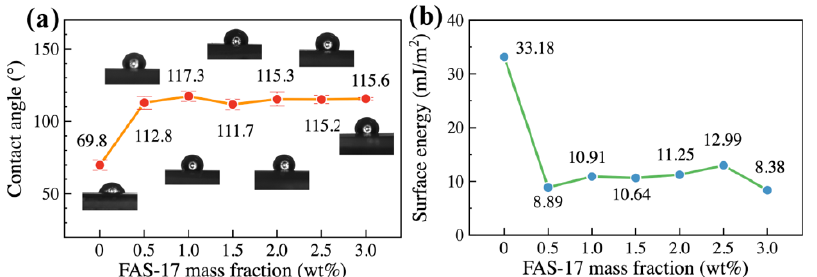
Figure 5. The contact angle (CA) and the surface energy of FAS-17-modified epoxy: ( a ) The water contact angle of epoxy modified with the FAS-17 mass fraction; ( b ) Surface energy of the epoxy resin modified with the FAS-17 mass fraction.